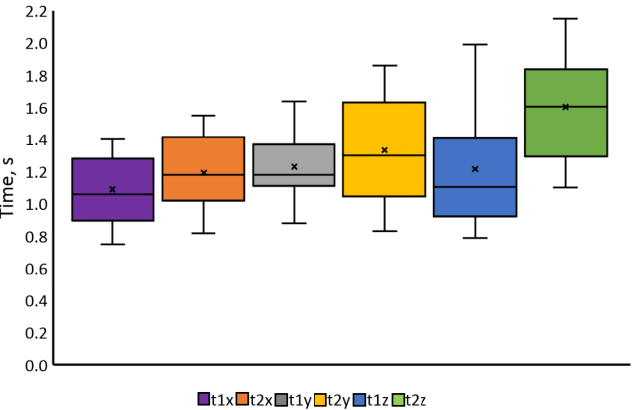
Figure 8. Duration of the individual stages of the movement, obtained during the study of the reaching movements of the hand.